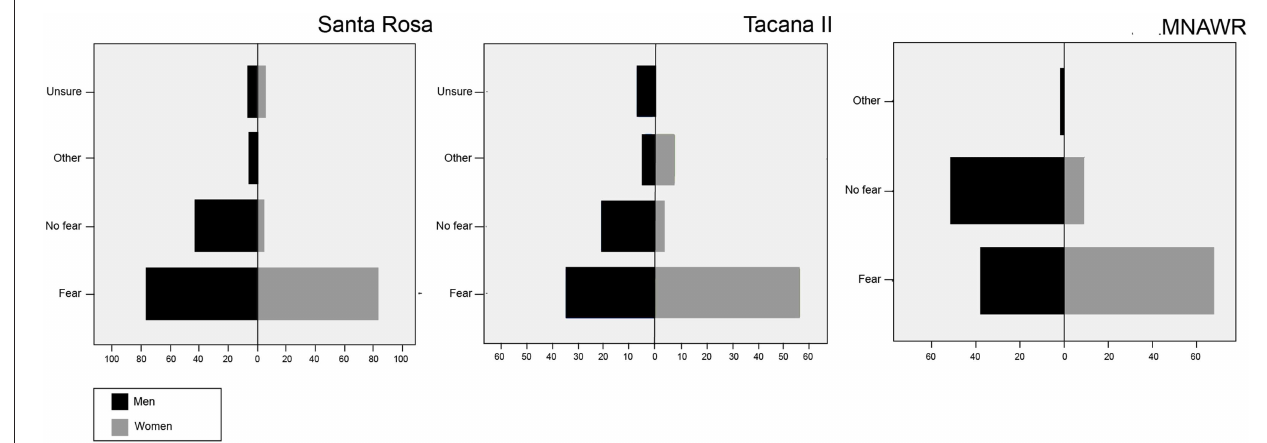
FIGURE 4 | Proportion of men and women fear to encounter jaguars, by area.